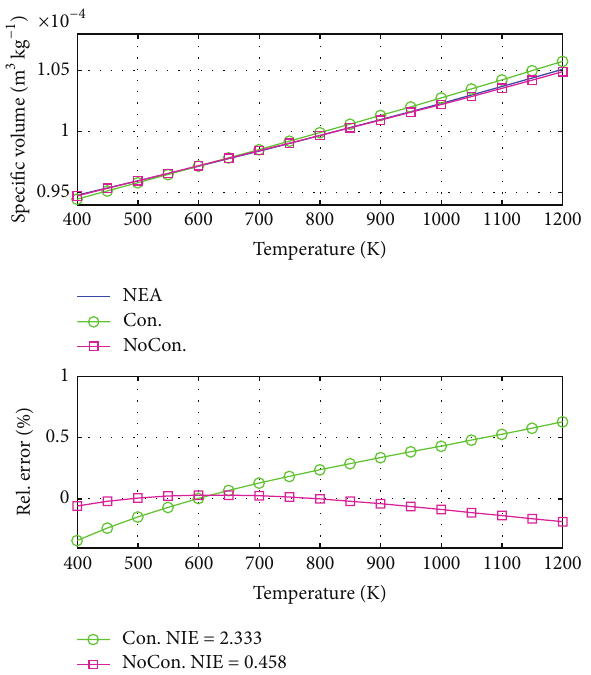
Figure 13: LBE specific volume, NEA data versus constrained and nonconstrained optimization results.